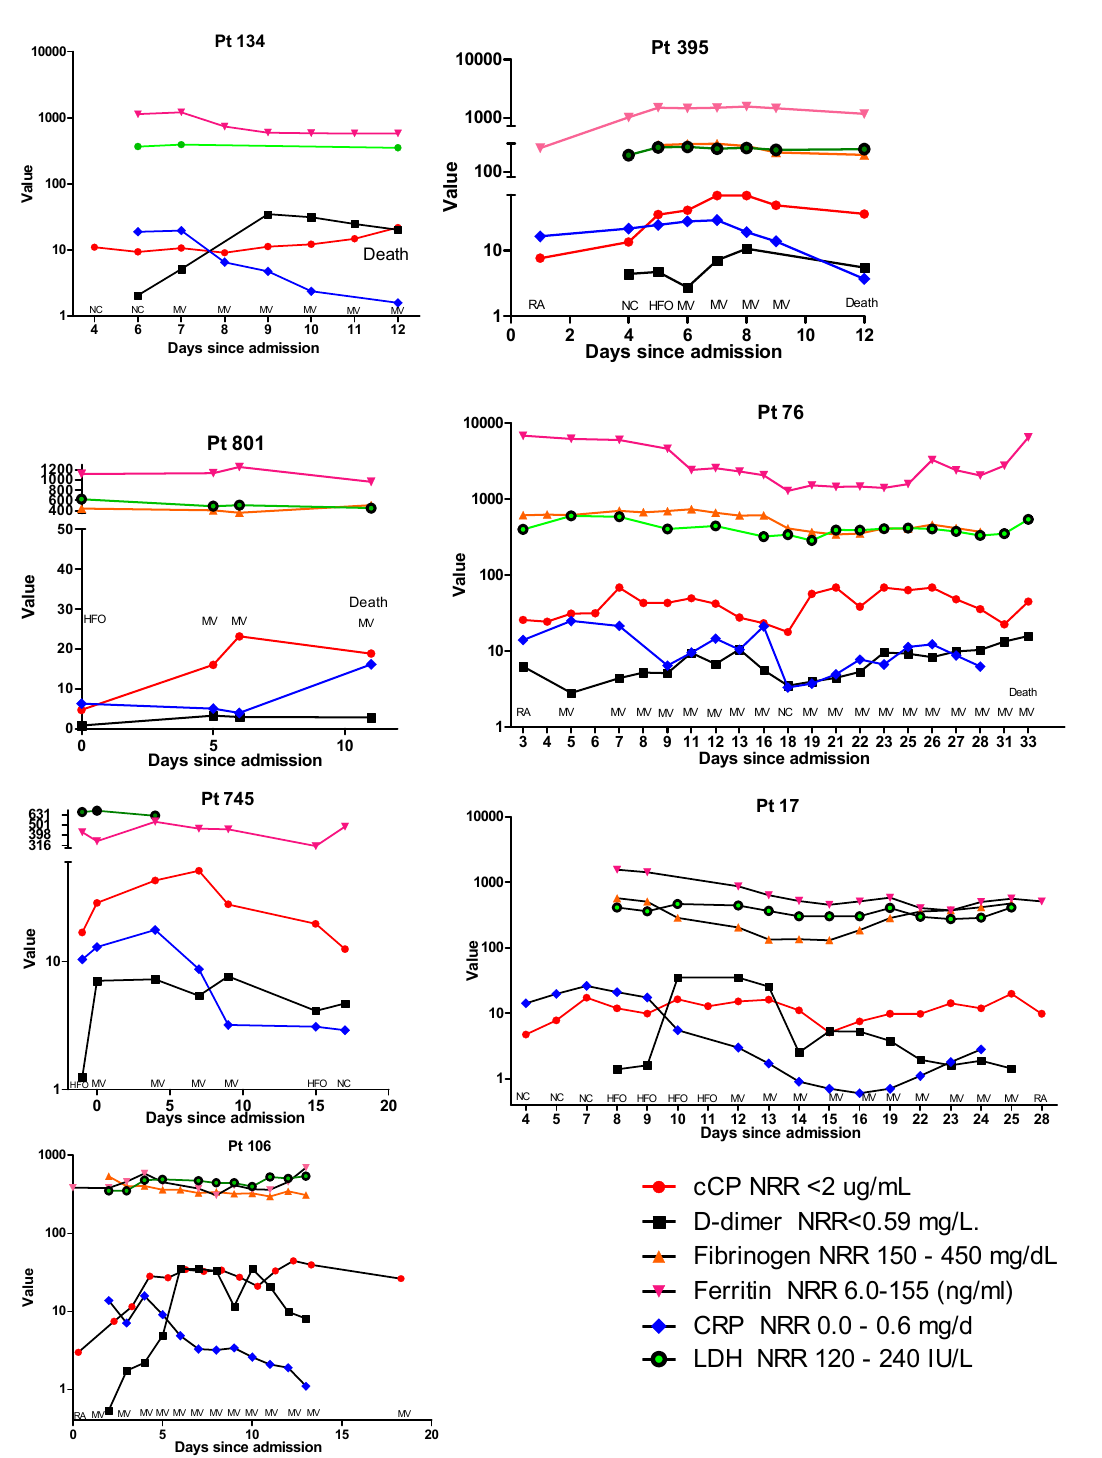
Figure 3. Comparative profiles of longitudinal biomarker changes, corresponding respiratory sup- plementation, and final outcomes of 4 hospitalized patients with COVID-19 who died (patients 134, 395, 801, and 76) and 3 patients who recovered (patients 745, 17, and 106). As a result of the widely different ranges of the various assays, the y-axis is presented in logarithmic scale, and in some panels has been split to accommodate very high values. Abbreviations: RA, room air; NC, nasal cannula; HFO, high-flow oxygen; MV, mechanical ventilation; NRR, normal reference range; CRP, C-reactive protein; LDH, lactate